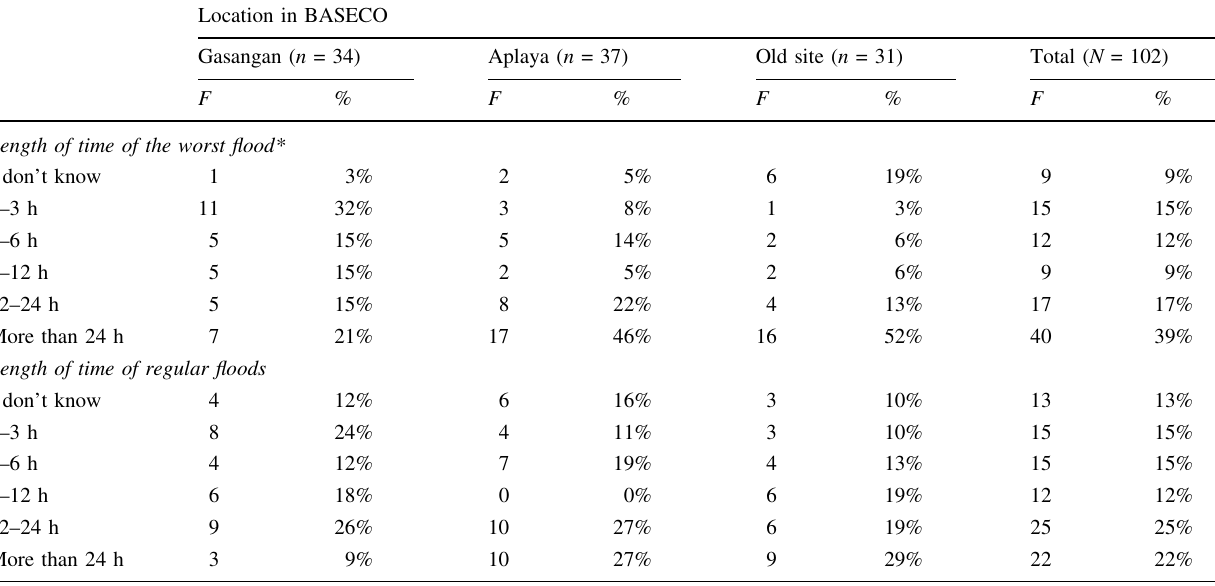
Table 1 Comparison between duration of worst flood and regular flood ( N = 102) in BASECO Compound in Manila Location in BASECO